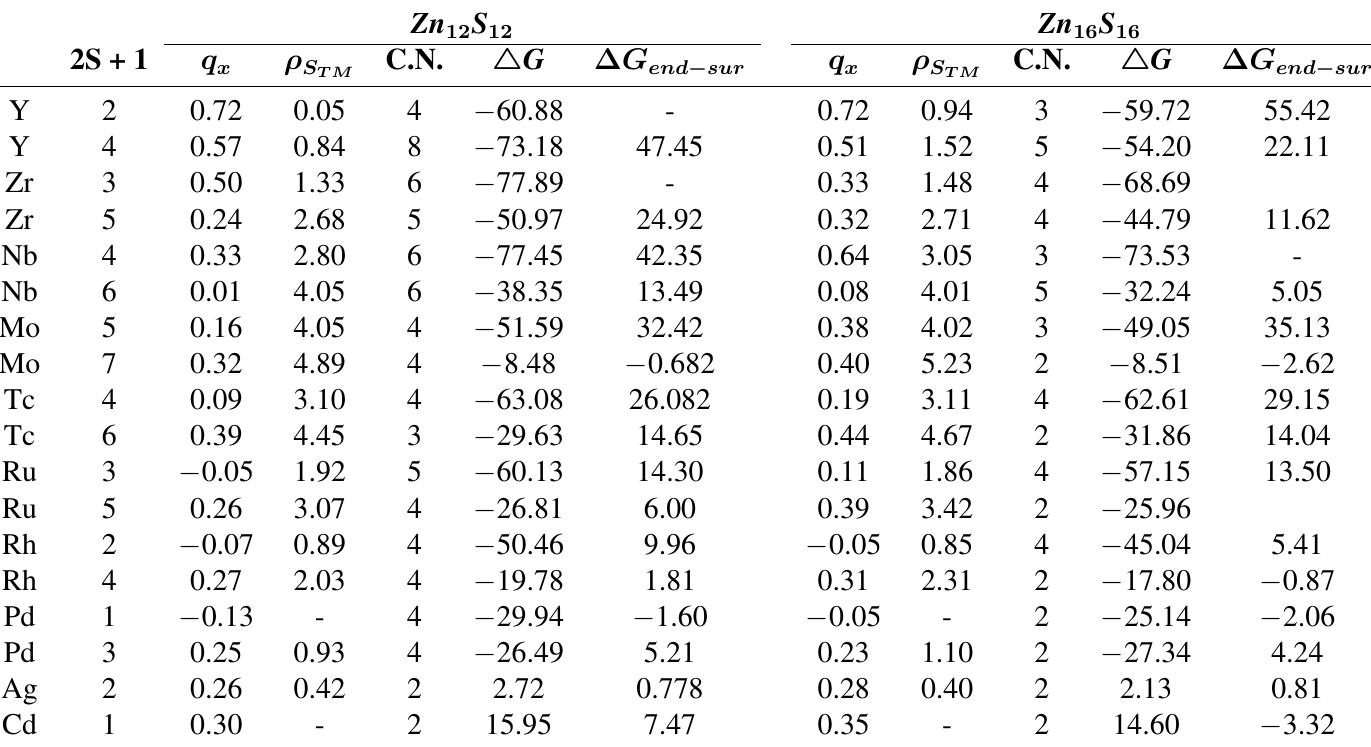
stands for the atomic charge, ρ for the spin density and the coordination number (CN), x S TM the energy difference between the endohedral and surface isomers end − sur